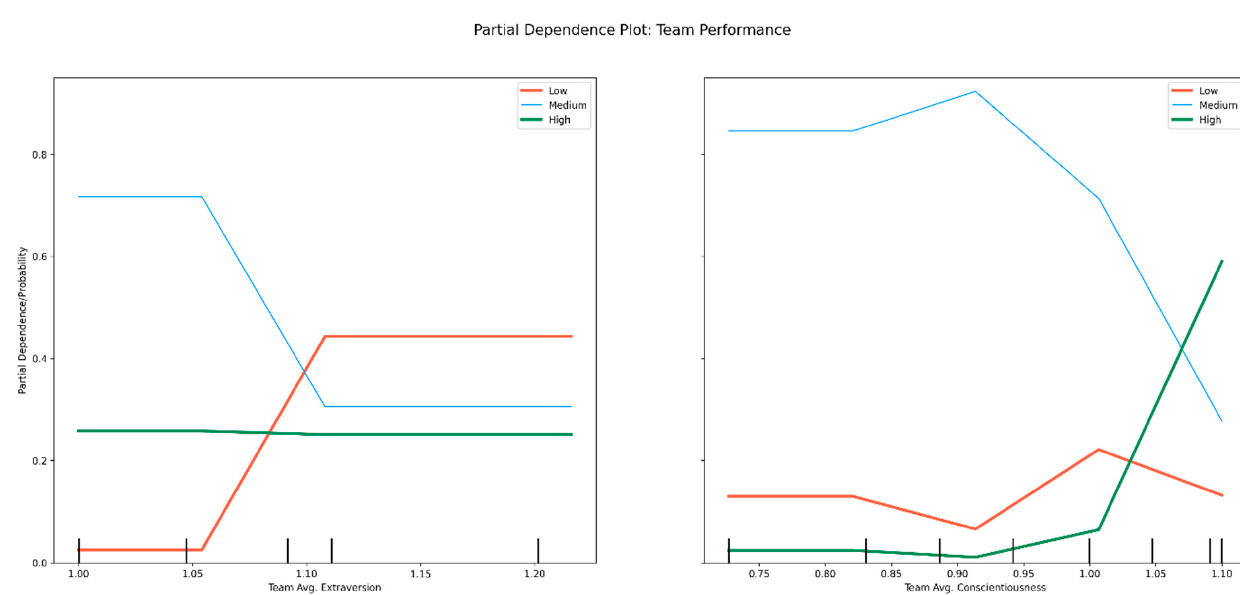
Figure A1. PDP of Team Performance Model.